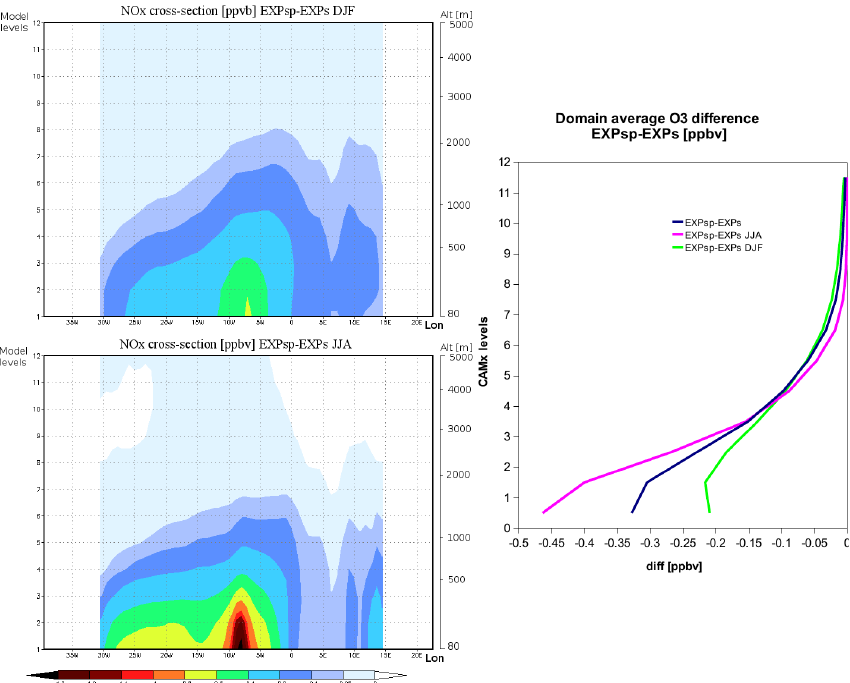
Fig. 9. Vertical cross-section along latitude 45.2 ◦ N of the difference between experiments EXPsp and EXPs for the winter (upper left) and summer season (lower left) for NO x in ppbv with approximate altitudes. On the right: plot showing the vertical profile of the difference of EXPsp and EXPs for winter (green), summer (pink) conditions and as annual average (dark blue) for ozone averaged spatially over the entire domain.